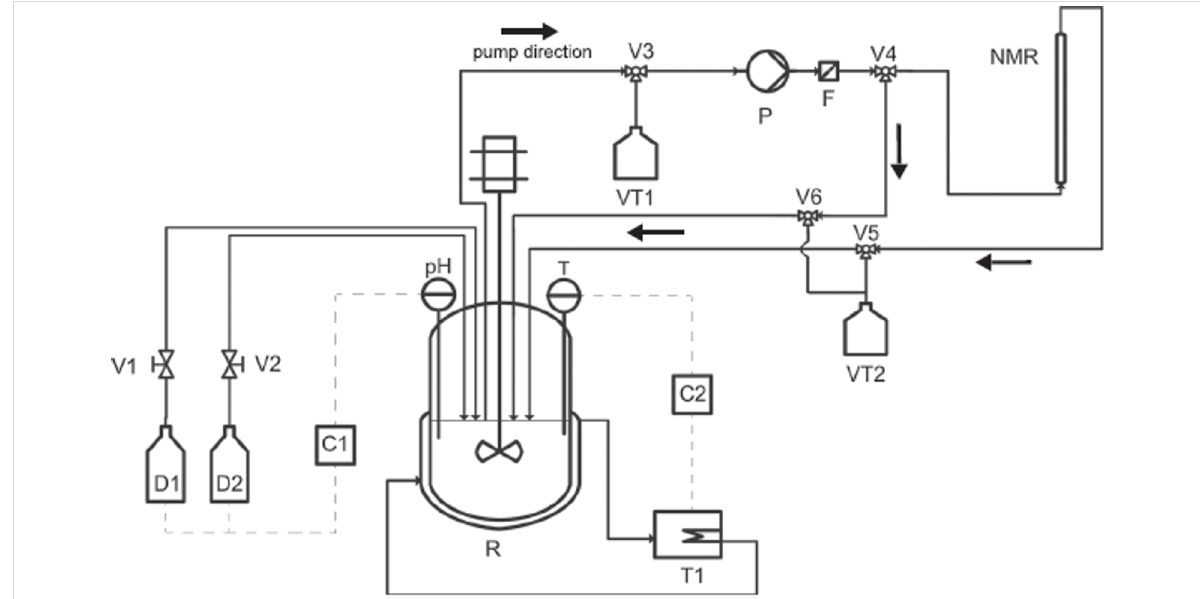
Figure 10: Design of the experimental setup used to combine on-line NMR spectroscopy and a batch reactor. Reproduced with permission from refer- ence [47]. Copyright 2015 John Wiley and Sons.